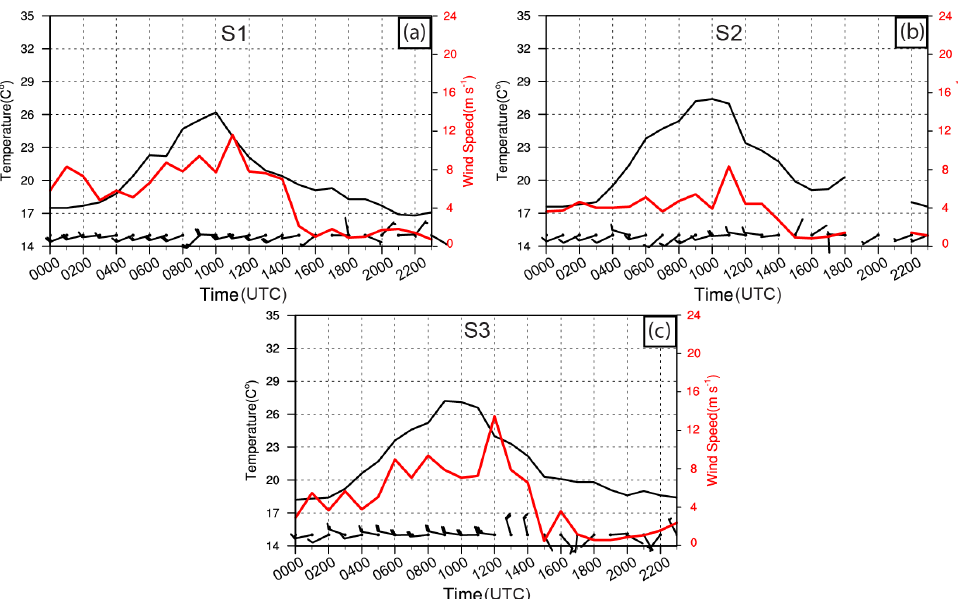
Figure 4. Evolution of observed temperature (black lines, units: ◦ C) and wind information (wind barbs, half and full wind barbs represent 2 and 4 m s −1 , respectively; red lines show the wind speed, units: m s −1 ) observed by ground-based automatic weather station ( a ) S1, ( b ) S2, and ( c ) S3, respec- tively (see the locations of S1, S2, and S3 in Figure 1a) from 0000 UTC to 2300 UTC on 17 June 2016. The discontinuities of lines (i.e., broken lines) in ( b ) from 1900 to 2100 UTC indicate the missing value at that time. The missing wind barbs are also due to the missing value at the corresponding time.